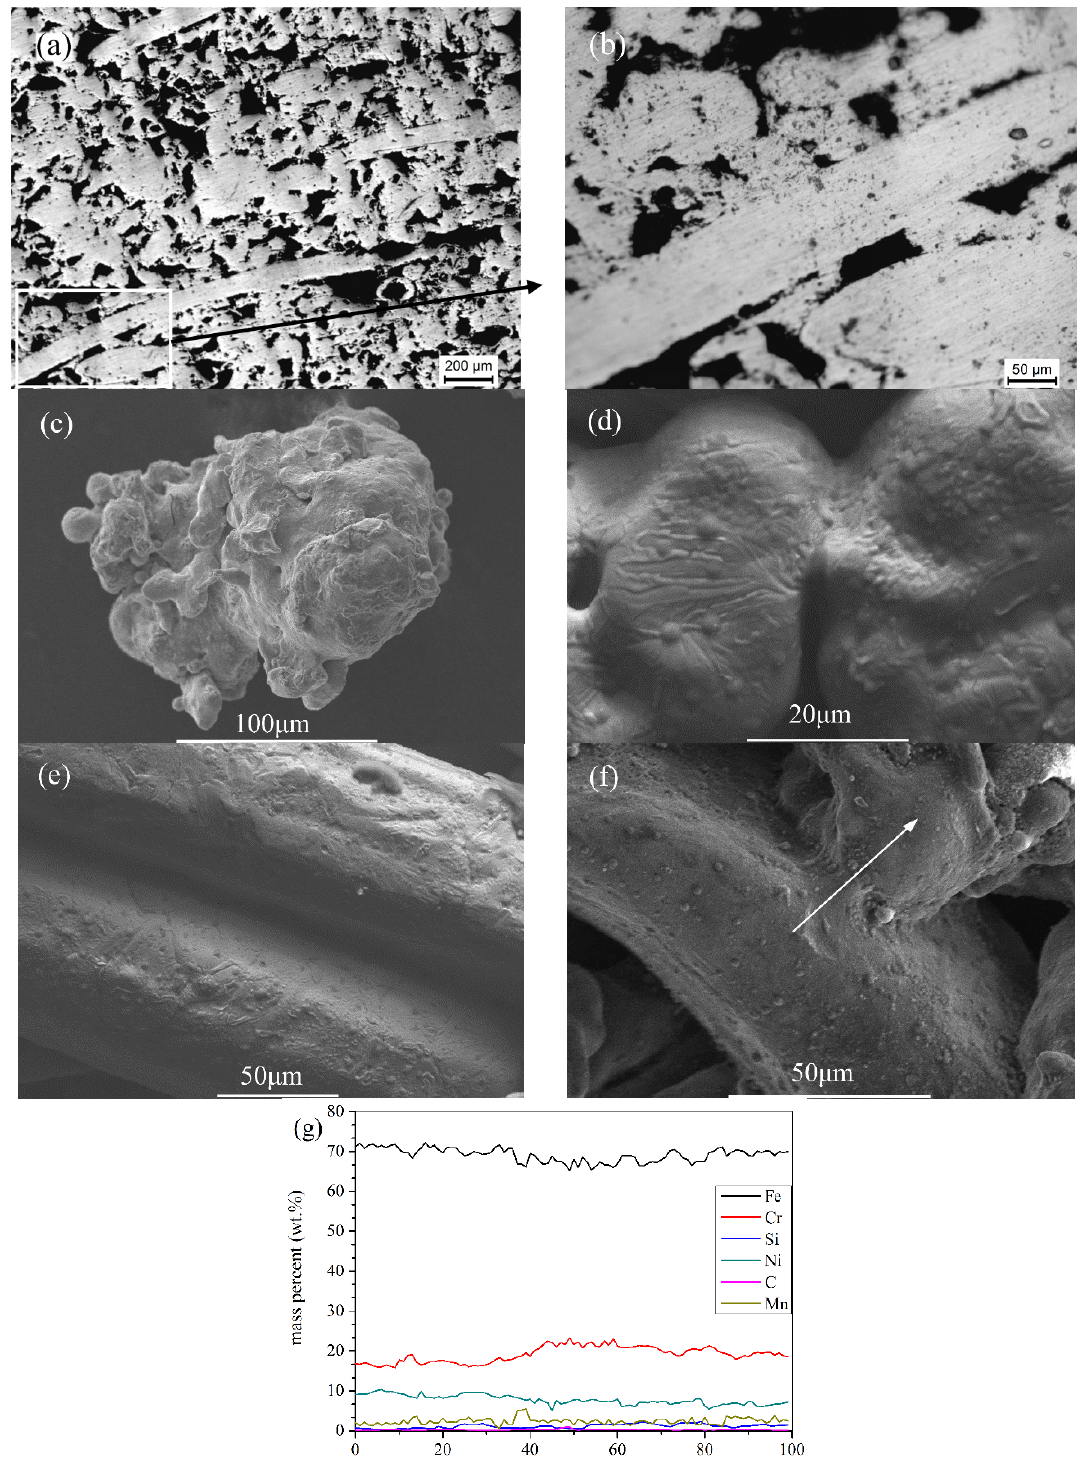
Figure 1. The metallographs of sample 2: ( a ) the structure of the P/M material in height direction; and ( b ) the area in high magnification; ( c ) irregularly shaped powder. SEM images of three sinteringjoints: ( d ) powder-to-powder sintering joint; ( e ) fiber-to-fiber sintering joint; and ( f ) powder-to-fiber sintering joint; ( g ) the linear EDS analysis of the sintering joint in ( f ).